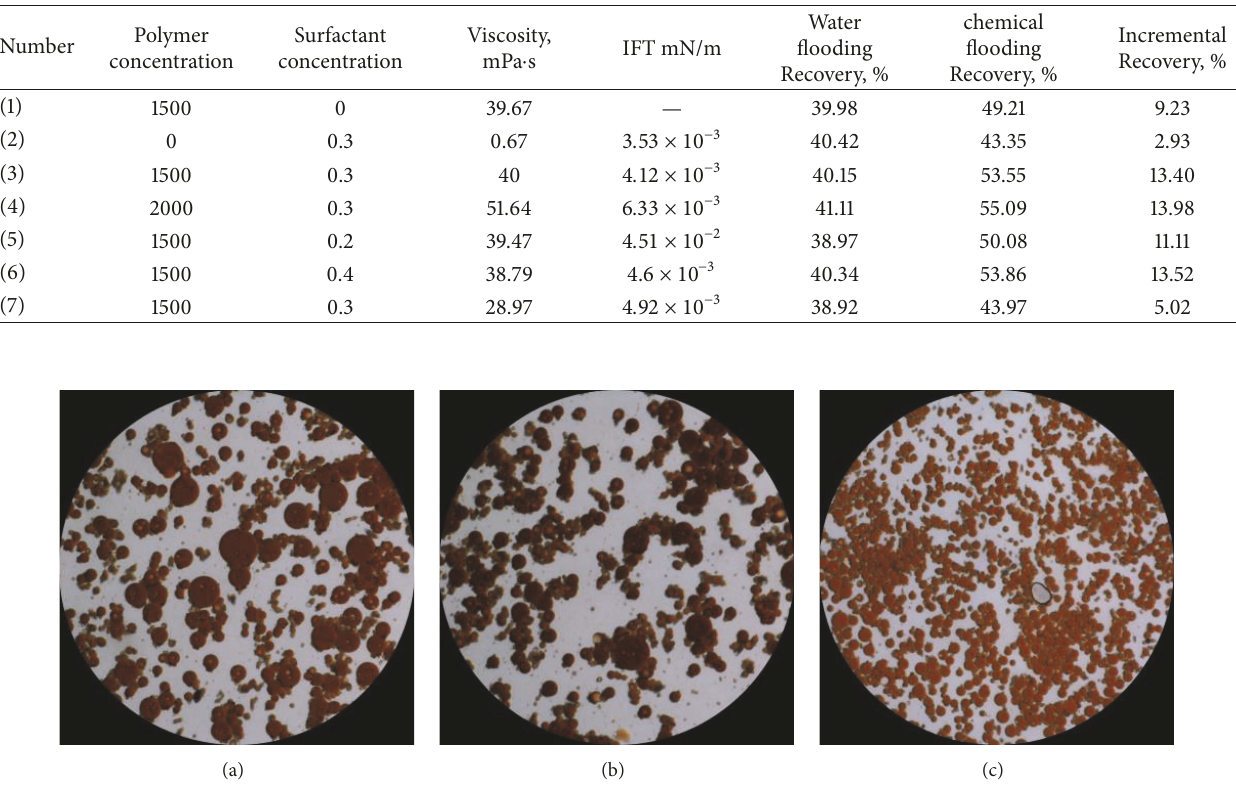
Figure 5: Micrographs of emulsions with different chemical agent: (a) 0.1wt% surfactant + 2000 mg/L polymer; (b) 0.2 wt% surfactant +